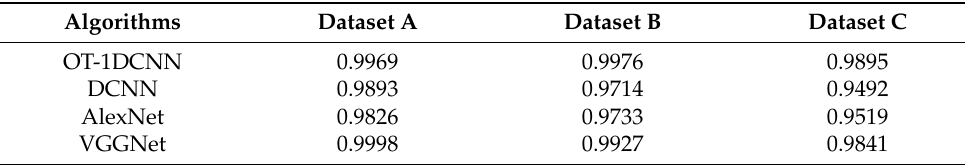
Table 5. The results of comparative experiments with CWRU data.